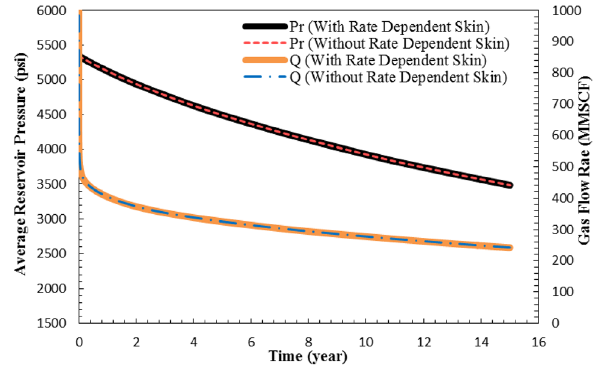
Fig. 13 Average reservoir pressure and gas production rate with and without rate-dependent